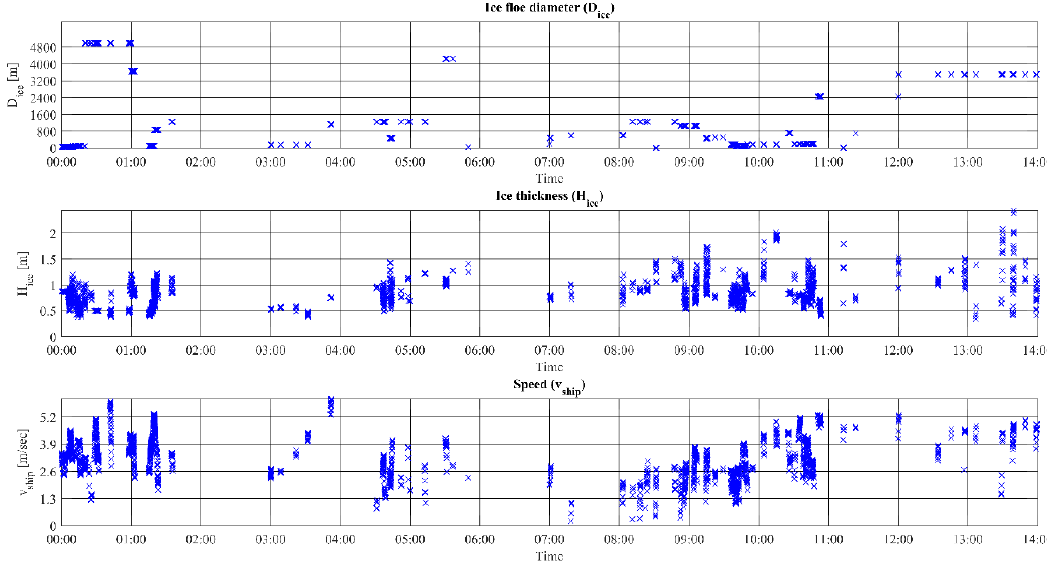
Figure 3. Extract from data set A, showing how the measured ice floe diameter, ice thickness and speed vary during a selected period of 14 h.